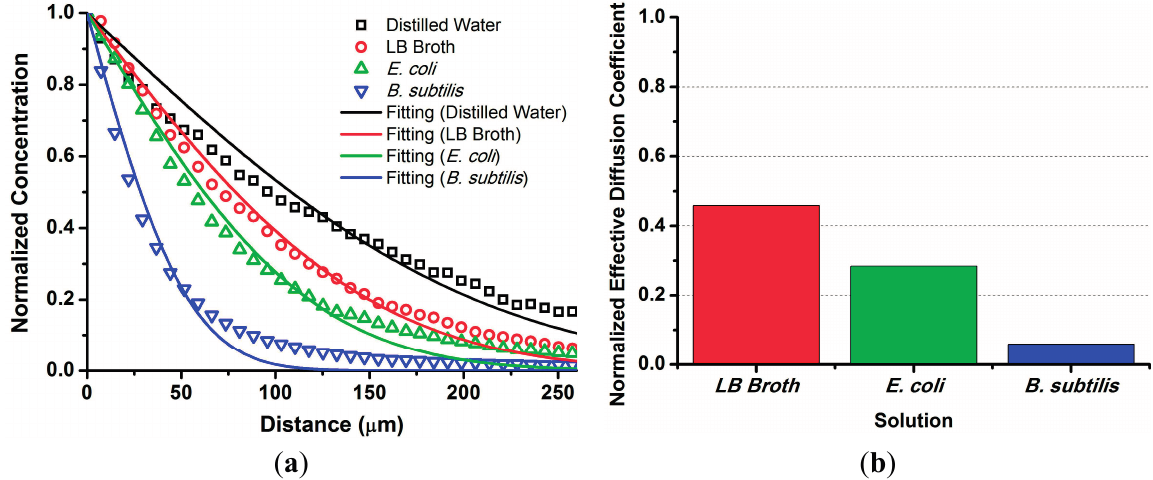
Figure 1. Dynamics of the submicron fluorescent beads. ( a ) Fluorescence intensity profile of the beads in each solution at 30 s after initiation of diffusion from the 0.5% agar plate. The symbols and lines represent experimental data and regression curves obtained by Equation (1), respectively; and ( b ) Comparison of D eff of the bead in different solutions. Measured D eff of the beads in LB Broth (LB), supernatants of E. coli and B. subtilis were normalized by D eff in distilled water (DW). The relative magnitudes are DW > LB > E. coli > B. subtilis